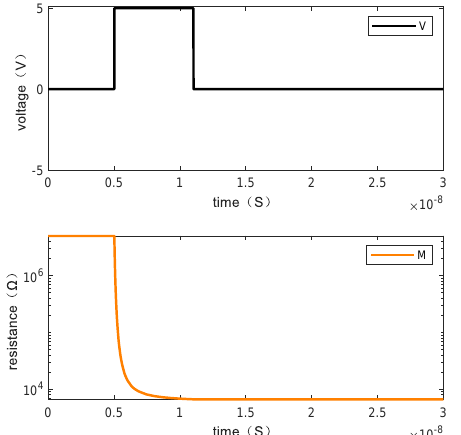
Figure 10. The changes of resistance value of the memory cell when writing “1110”.